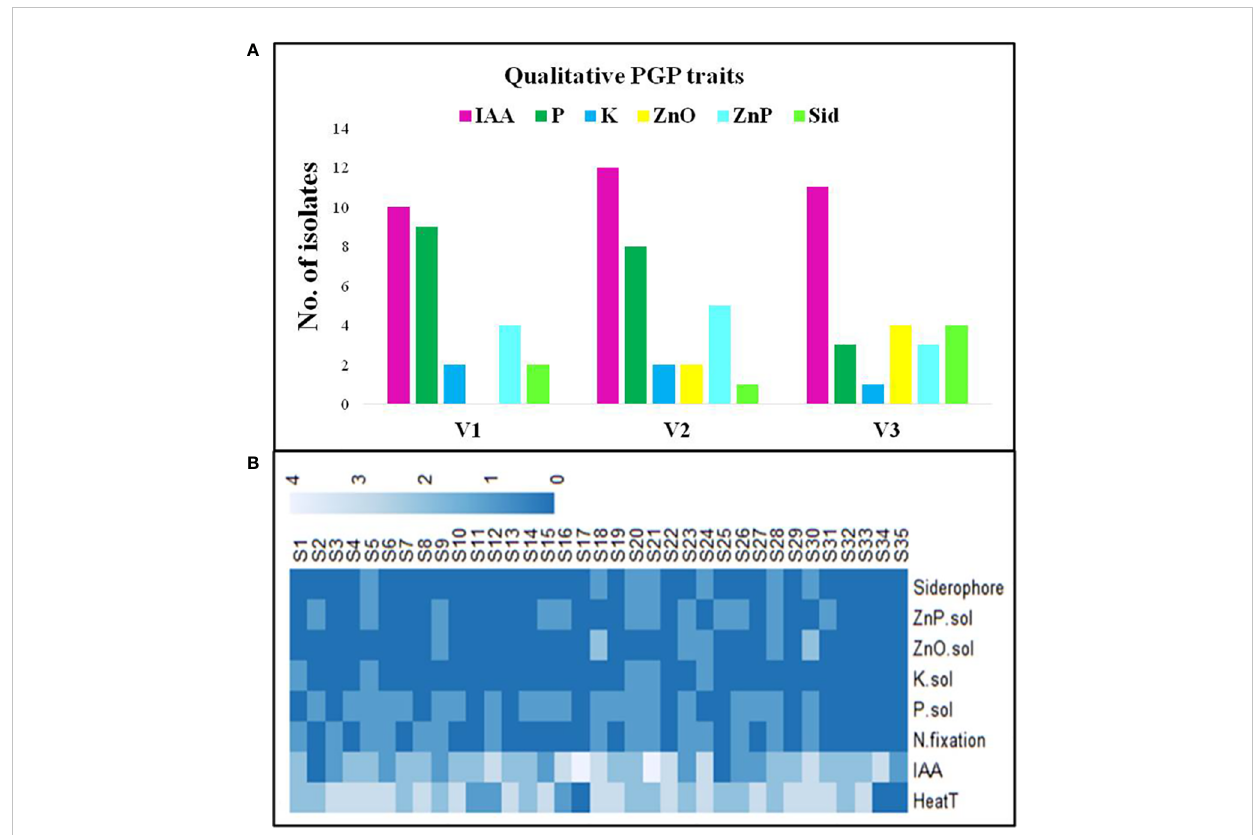
FIGURE 3 Plant growth-promoting (PGP) characteristics of WSEB isolates from three contrasting wheat varieties — heat S (GW322) and heat T (HD3298 and HD3271). (A) Graph representing the number of WSEB isolates showing PGP activities. (B) Bonitur scale of PGP attributes shown by selected heat T WSEB isolates (IAA, indole acetic acid; N, nitrogen fi xation; P, phosphorus solubilization; K, potassium solubilization; Sid, siderophore production; ZnO and ZnP — zinc oxide and zinc phosphate